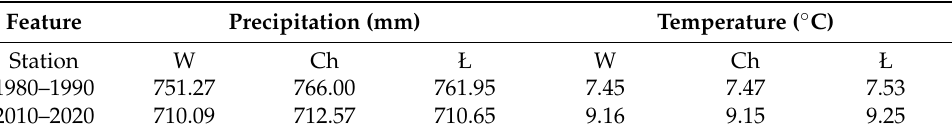
Table 1. Meteorological data from the 3 weather stations (W—Włodawa, Ch—Chełm, and Ł—Ł˛eczna) according to meteoblu over two periods (1980–1990;